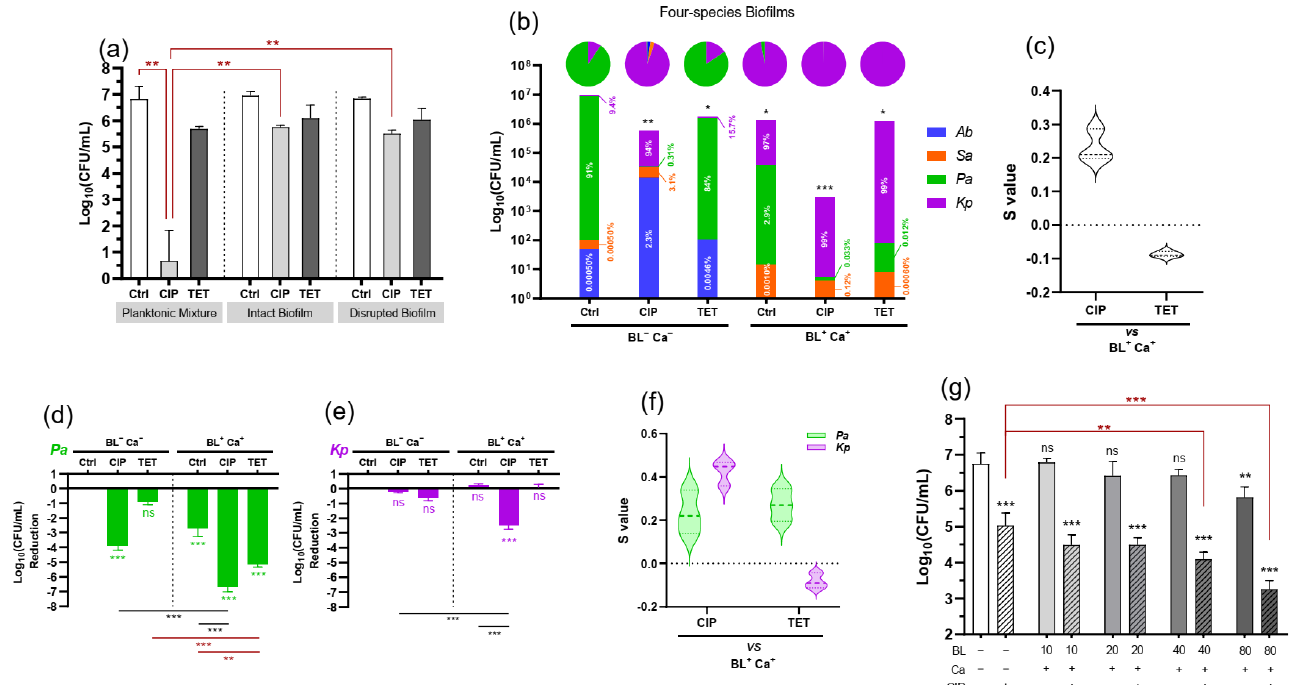
Figure 2. BL-Ca treatment enhances ciprofloxacin potency on polymicrobial biofilms. ( a ) Biofilm-associated tolerance to ciprofloxacin (CIP) or tetracycline (TET) as compared with the planktonic mixture with a similar composition. The bacteria either in intact or disrupted biofilm or planktonic culture were exposed to CIP (10 µg/mL) or TET (40 µg/mL) for 5-h in BHI medium, after which bacteria (Log 10 CFU/mL) survived the treatment were determined. ( b ) Stacked bar chart showing survived bacteria after different treatments. Pie charts above each column depicted corresponding species compositions in linear scale. ( c ) Synergy of BL-Ca treatment and antibiotics on biofilm survival. ( d , e ) Log reductions of biofilm-associated P. aeruginosa ( d ) and K. pneumoniae ( e ) after different treatments. ( f ) Synergy of BL-Ca treatment and antibiotics on the survival of embedded P. aeruginosa or K. pneumoniae determined by S values as detailed in Materials and Methods. 0 < S < 1 indicates a synergistic interaction, whereas S < 0 indicates an antagonistic interaction. ( g ) Increasing BL irradiance could enhance the potentiation of CIP on polymicrobial biofilms. Sa : S. aureus ; Ec : E. coli ; Kp : K. pneumoniae ; Ab : A. baumannii ; Pa : P. aeruginosa . *** p < 0.001; ** p < 0.01; * p < 0.05; and ns, no